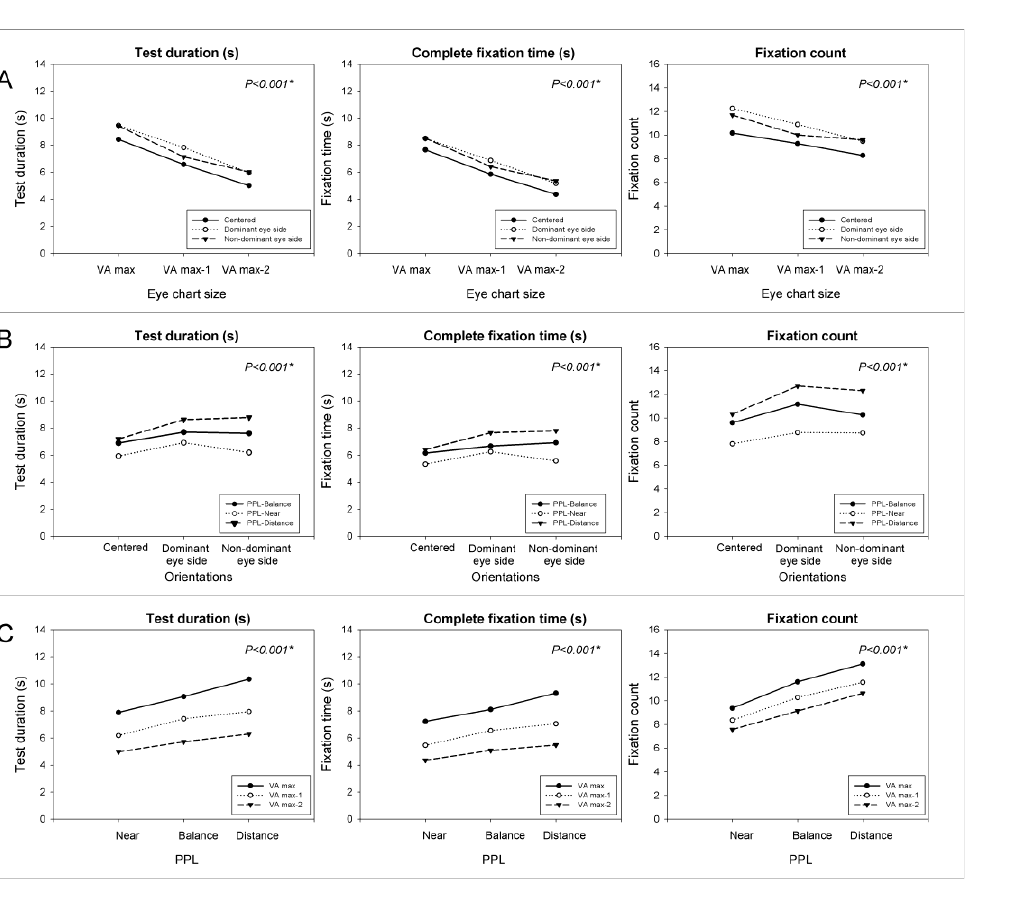
Figure 5. Variations in test duration, complete fixation time, and fixation count depending on the interactions of eye chart size and gaze direction ( A ), the gaze directions and PPL ( B ), and PPL and eye chart ( C ) for near-distance VA task. * Shows significance at the 0.05 level.